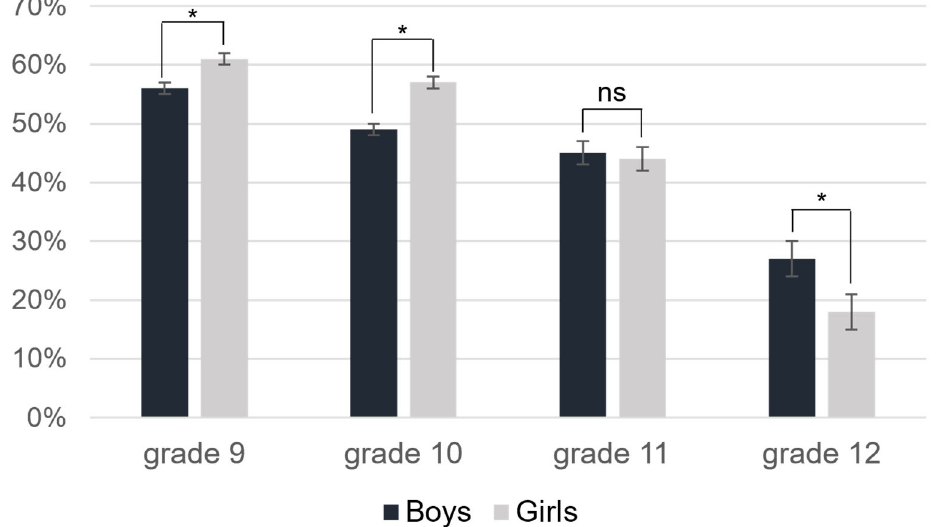
Figure 1. Four-year percentage changes of cardiorespiratory fitness performance in healthy fitness zone, * p < 0.05. Table 3. Estimated proportion and odds ratio of youth in healthy fitness zone (HFZ).